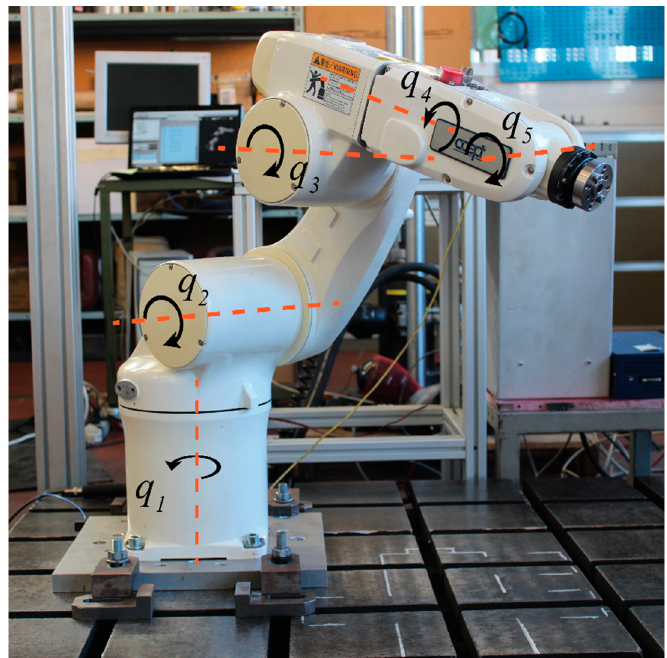
Figure 1. The robot Adept Viper s650 with the tested axes.